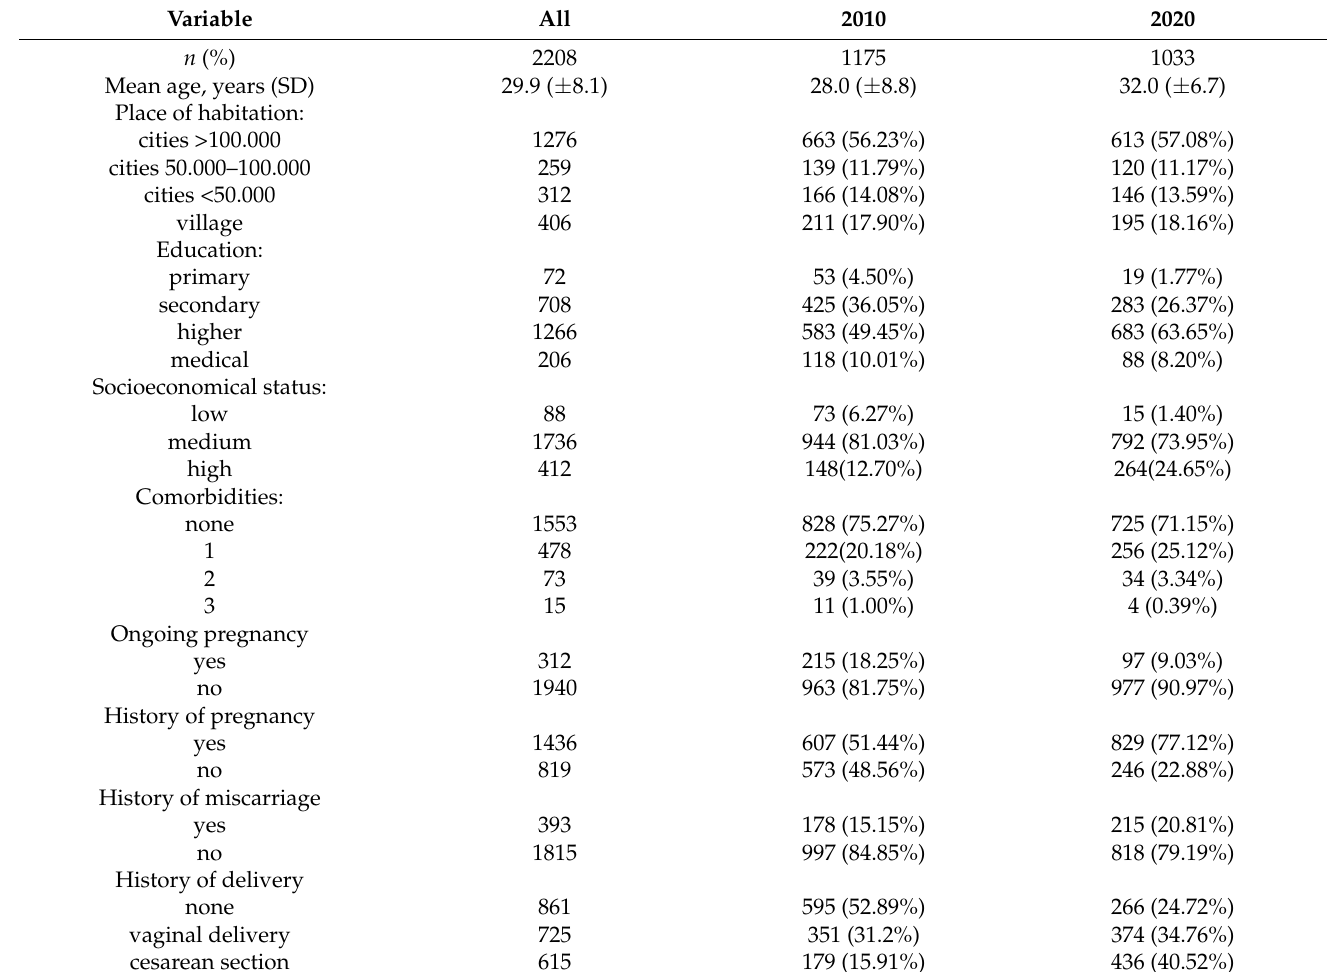
Table 1. Basic characteristics and obstetric history of the study